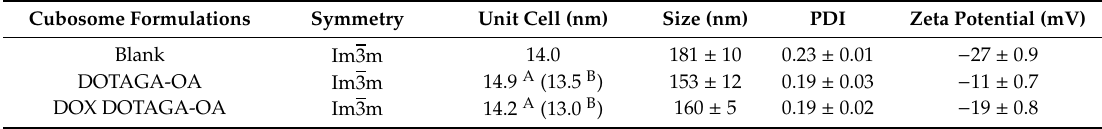
Table 3. Properties of cubosome formulations determined using SAXS and dynamic light scattering (DLS).